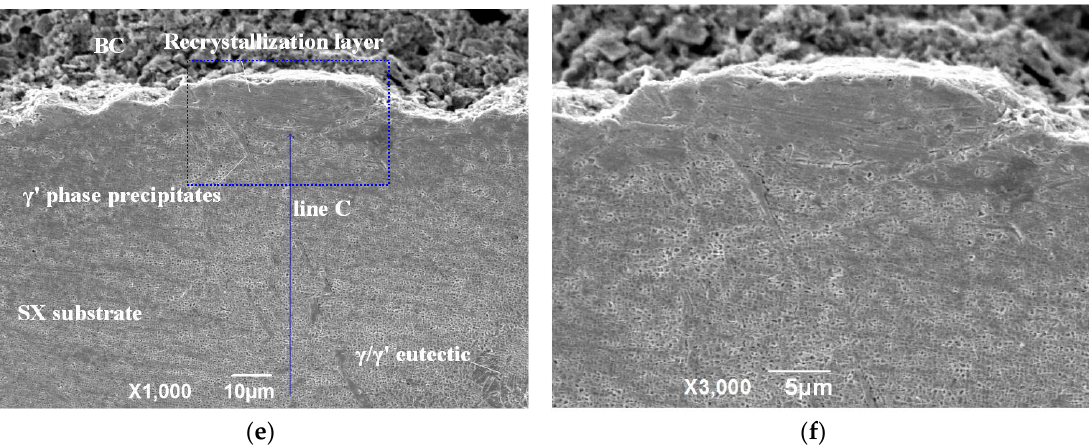
Figure 5. SX superalloy microstructure close to the interface of ( a , b ) NPT-A, ( c , d ) PT-A and ( e , f ) PT-B samples after heat treatment.